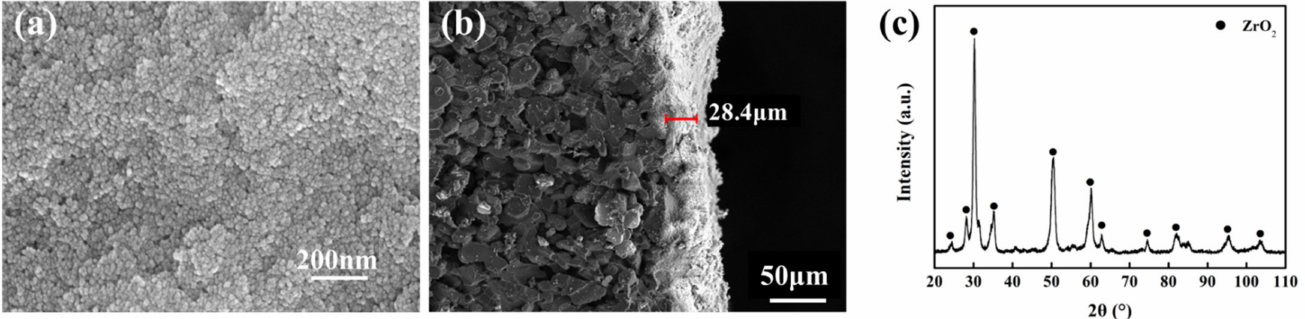
Figure 5. Microscopic morphology of the ZrO 2 /TiO 2 /Al 2 O 3 composite nanofiltration membrane (ZTA composite membrane) (The surface ( a ) and the cross-section ( b ) of the composite membrane). ( c ) X-ray phase analysis of the ZTA composite membrane surface.